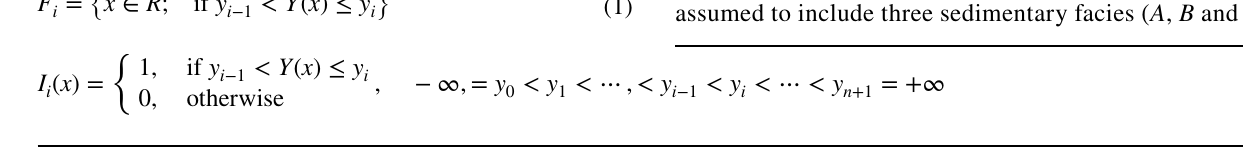
Table 1 Quantitative relationships between facies A, B, C and diagenetic phases P1, P2, P3